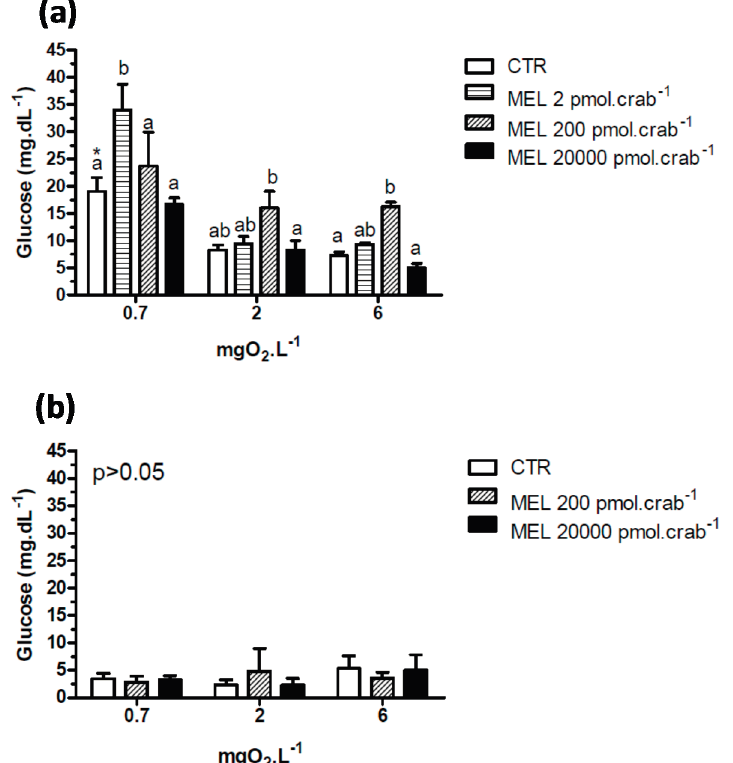
Figure 4. Circulating glucose concentration in ( a ) intact and ( b ) eyestalkless Neohelice granulata exposed for 45 min to three different dissolved-oxygen concentrations (0.7, 2 or 6 mgO 2 ·L − 1 ) and injected with physiological saline (CTR) or melatonin (2, 200 or 20,000 pmol·crab − 1 ). Each point represents the mean ± SE ( n = 4–7). Different letters represent significant differences ( p < 0.05) between the groups with the same dissolved oxygen concentration. Different letters represent significant differences ( p < 0.05) between the